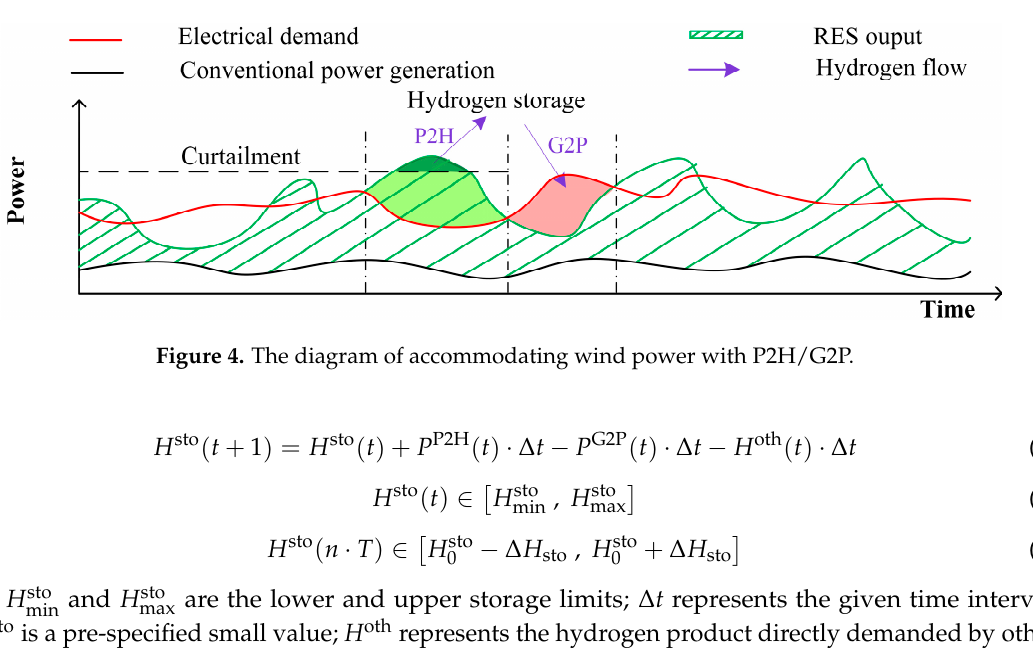
Figure 3. Schematic of P2H/G2P concept. P2H/G2P: Power-to-Hydrogen and Gas-to-Power.